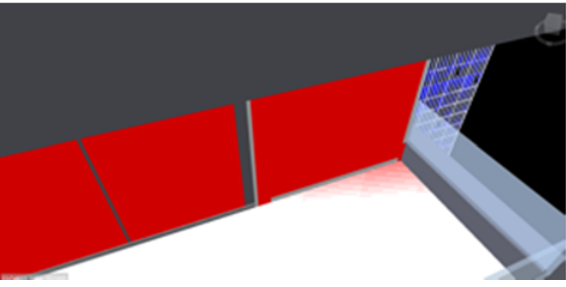
Figure 9. Balcony of the residential building in the Amsterdam case is not enclosed by legal volume ( red ).